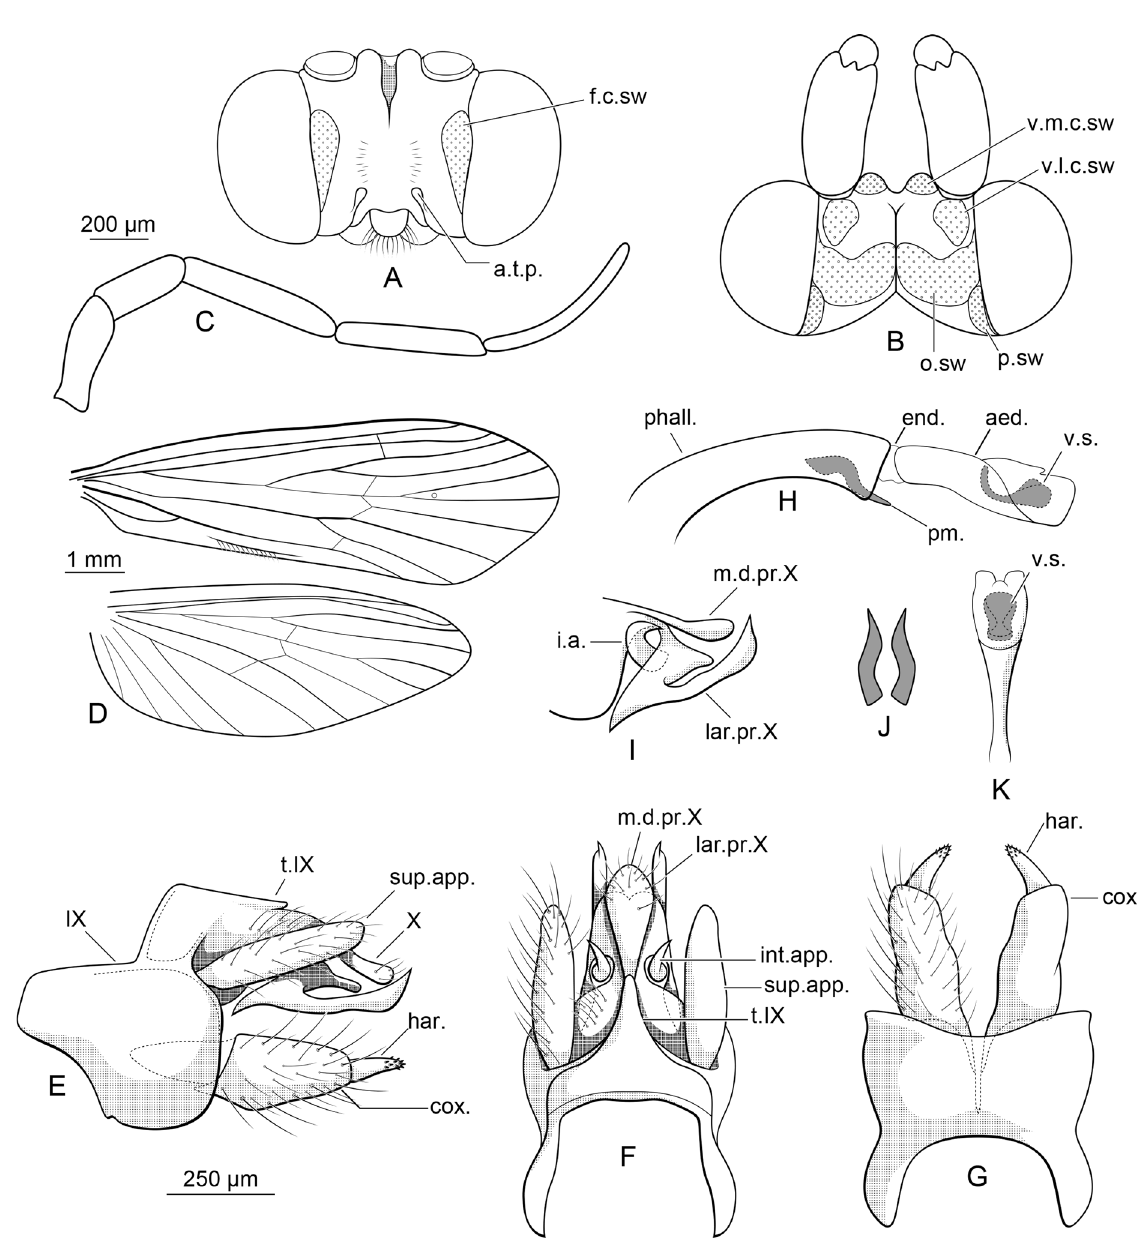
Fig. 1. Psilotreta daidalos Malicky 2000. A . Head, anterior view. B . Head, dorsal view. C . Maxillary palp. D . Wing veins. E . Male genitalia, left lateral view. F . Male genitalia, dorsal view. G . Male genitalia, ventral view. H . Phallus, left lateral view. I . Segment X, left lateral view. J . Parameres, ventral view. K . Aedeagus, ventral view. Scale bars: A–C = 200 µm; D = 1 mm; E–K = 250